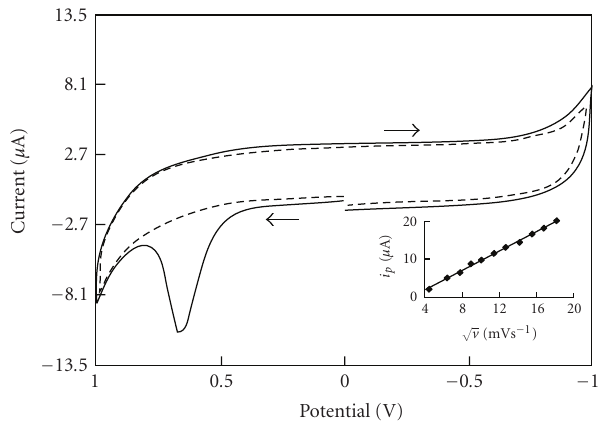
Figure 3: Cyclic voltammogram for 5000 ng/mL of salbutamol at SWNT-modified EPPGE (—) and background PBS at SWNT- modified EPPGE (---) at pH 7.2 and scan rate of 20 mV/S. Inset: E ff ect of scan rate ( v ) on peak current ( i p ) of